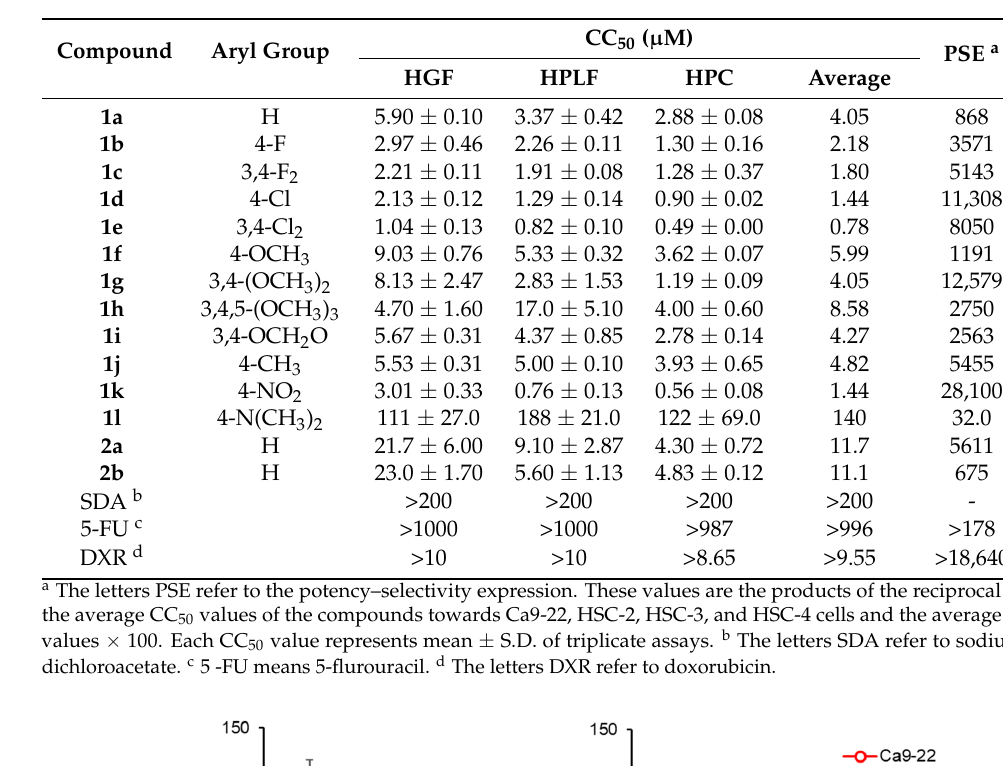
Table 2. Evaluation of 1a – l and 2a , b against human HGF, HPLF, and HPC non-malignant cells. Compound